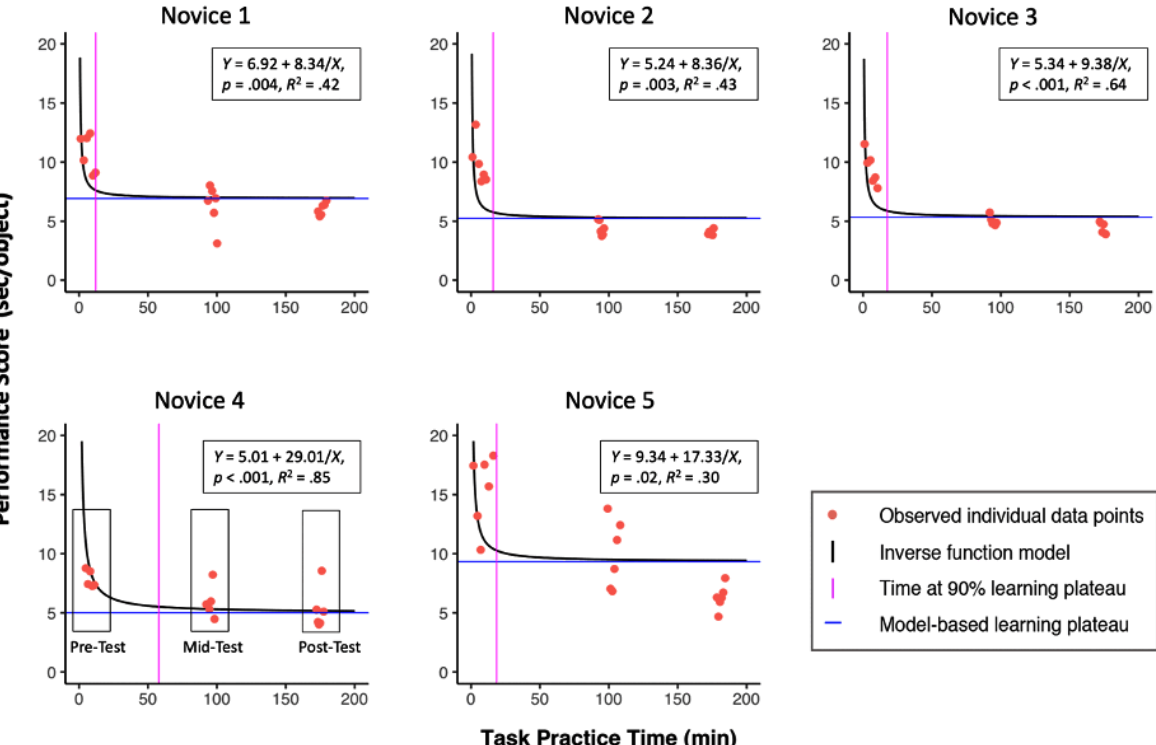
Figure 3. Individual data points, learning curves, inverse model functions and plateaus for novices across training. Exemplar boxes shown on Novice 4 are to illustrate the groups of data points that combine to calculate the pre-, mid-, and post-test